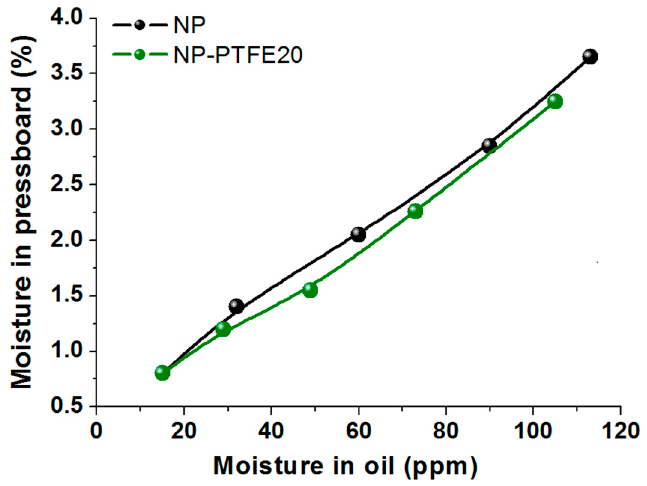
Figure 14. Moisture balance between paper and oil at 70 °C.